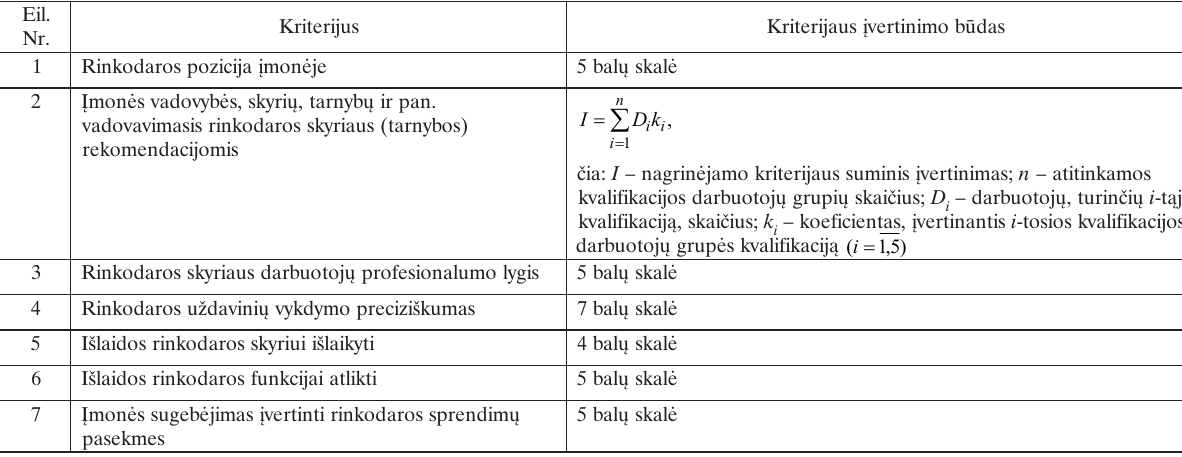
Table 1 . Scales of enterprise marketing evaluation criteria